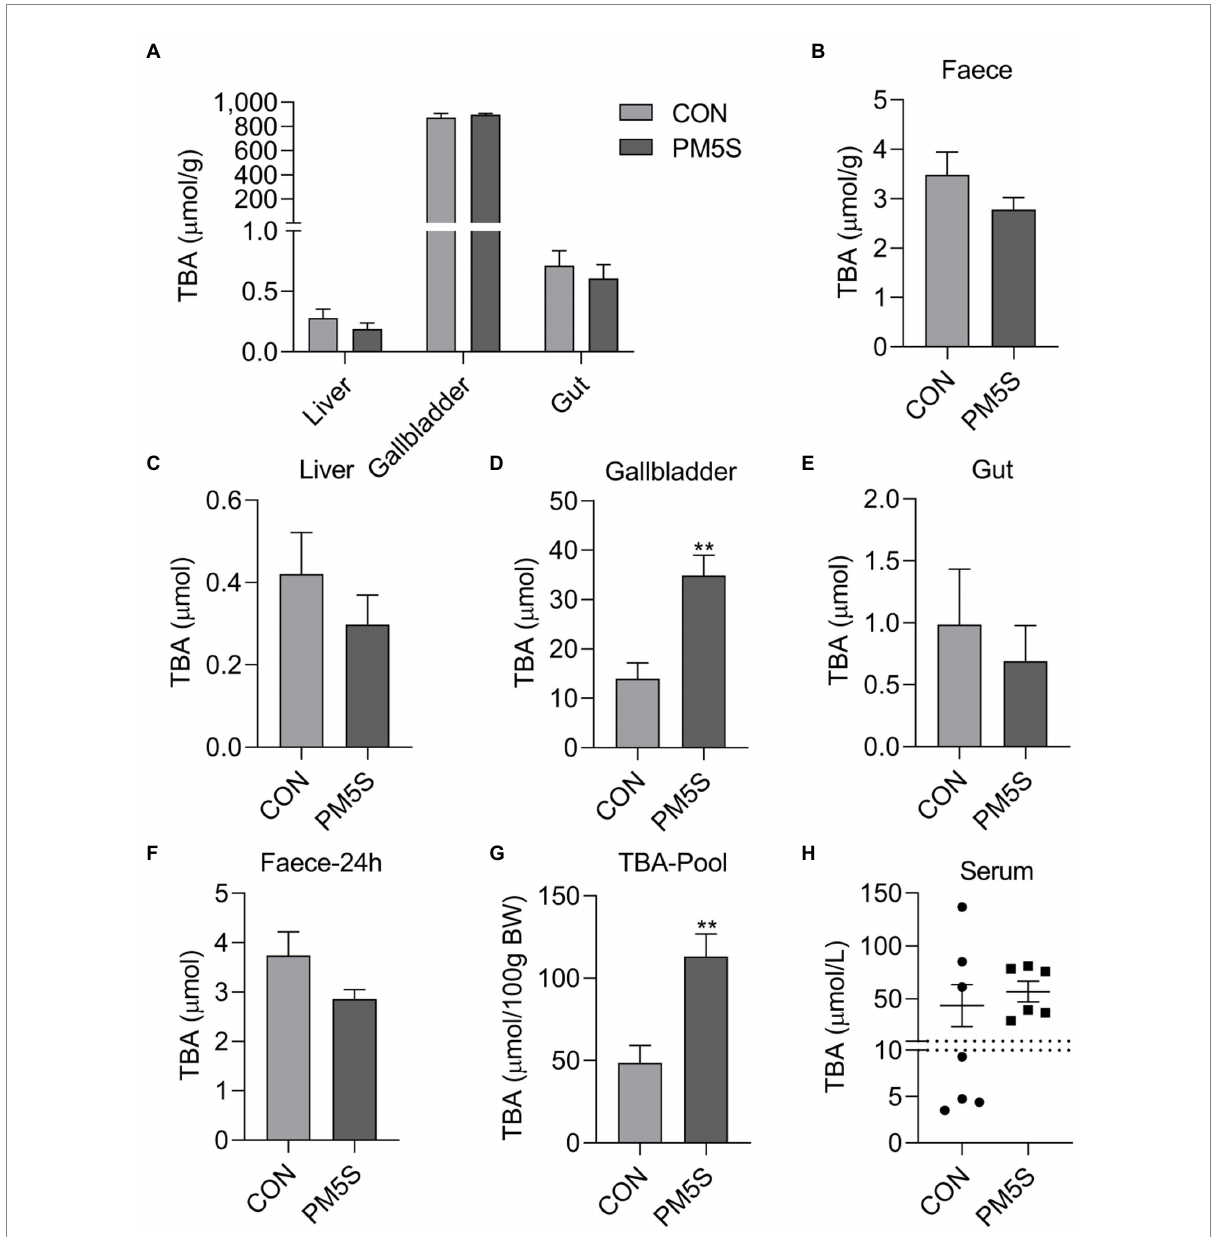
FIGURE 7 PM5S treatment changed BA metabolism of pregnant mice. The effect of PM5S treatment on TBA levels of (A) liver, gallbladder, gut and (B) feces in pregnant mice; (E) , The effect of PM5S treatment on TBA content of (C) liver, (D) gallbladder, (E) gut and (F) fecal BA secretion within 24-h in pregnant mice; (G) , The effect of PM5S treatment on (G) TBA pool and (H) serum TBA levels in pregnant mice. Data are shown as means ± SE, ** p <